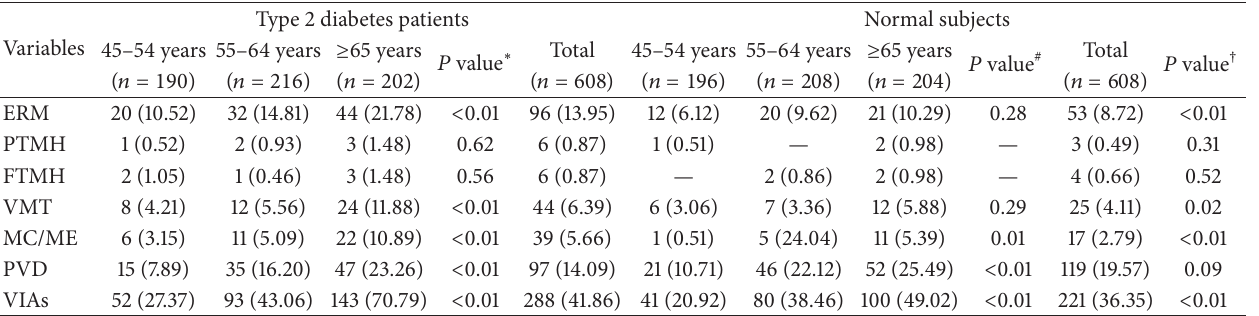
Table 5: The prevalence of VIAs within all subjects in this study (number of eyes or